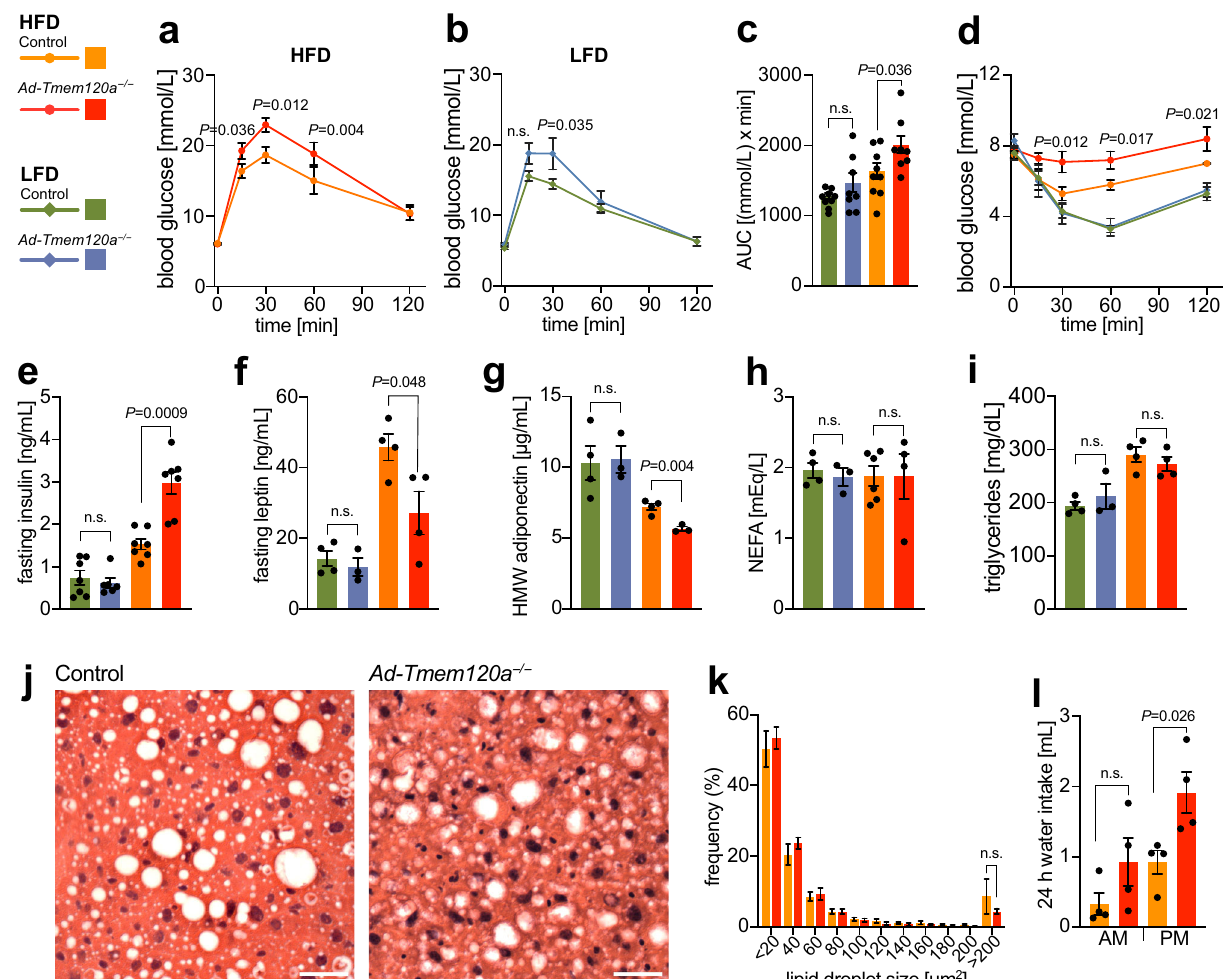
Fig. 2 Insulin resistance in Ad-Tmem120a -/- mice. Glucose tolerance test in control and Ad-Tmem120a − / − females on HFD ( a ) and LFD ( b ), fasting for 16h, and quanti fi cation of the area under the curve (AUC) ( c ), panels shown as mean±SEM, control LFD n = 9, Ad-Tmem120a − / − LFD n = 8, control HFD n = 9, Ad- Tmem120a − / − n = 9. d Insulin tolerance test in control and Ad-Tmem120a − / − females on LFD vs HFD, fasting for 6h, shown as mean±SEM, control LFD n = 7, Ad-Tmem120a − / − LFD n = 6, control HFD n = 9, Ad-Tmem120a − / − n = 6. Blood biochemistry. Fasting serum insulin ( e ), fasting leptin ( f ), high molecular weight (HMW) adiponectin ( g ), NEFA — nonestri fi ed fatty acids ( h ), and triglycerides levels ( i ) in control and Ad-Tmem120a − / − females on LFD vs HFD, fasting for 16h, shown as mean±SEM, control LFD n = 4, Ad-Tmem120a − / − LFD n = 3, control HFD n = 4, Ad-Tmem120a − / − n = 4. j Representative images of haematoxylin and eosin-stained liver sections from control and Ad-Tmem120a − / − female mice on HFD, scale bars: 40 µ m. k Quanti fi cation of lipid droplet size in liver form control and Ad-Tmem120a − / − females on HFD, the sizes of the lipid droplets were assigned to size bins and are shown as frequency, area in µ m2, shown as mean±SEM, control HFD n = 9, Ad-Tmem120a − / − n = 9. l Mean daily water intake by control and Ad-Tmem120a − / − females after 10 weeks on HFD, shown as mean±SEM, (for each group n = 4), P values: by unpaired, two-sided Student ’ s t test. Source data are provided as a Source Data fi